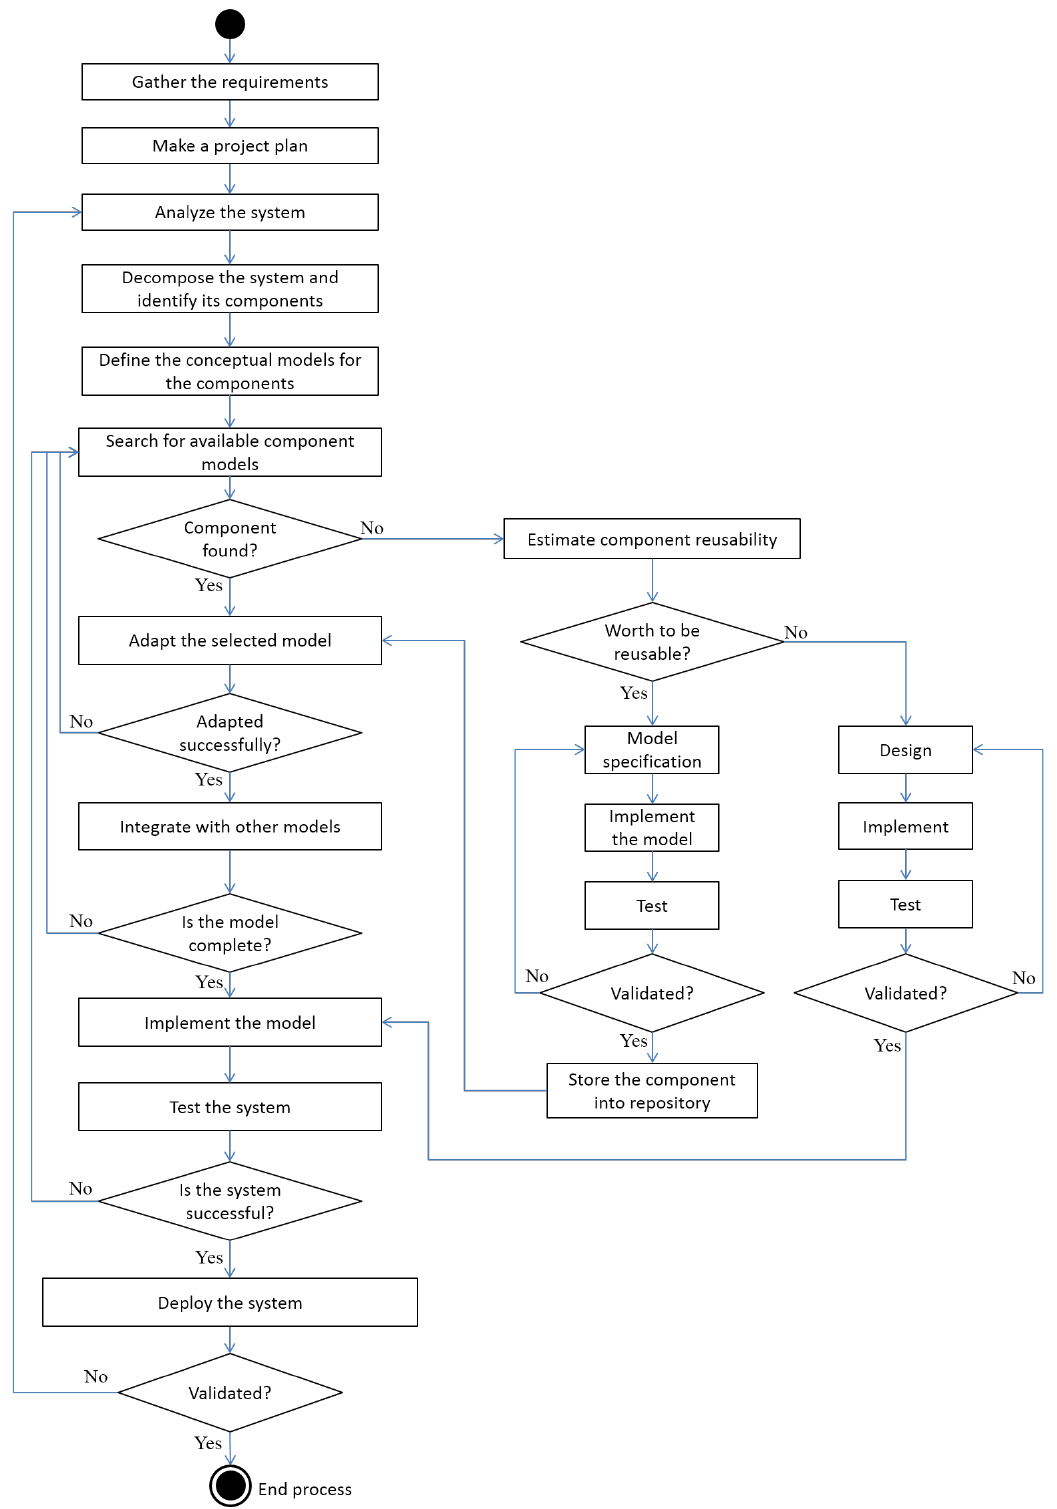
Figure 3. A sample workflow for the proposed process